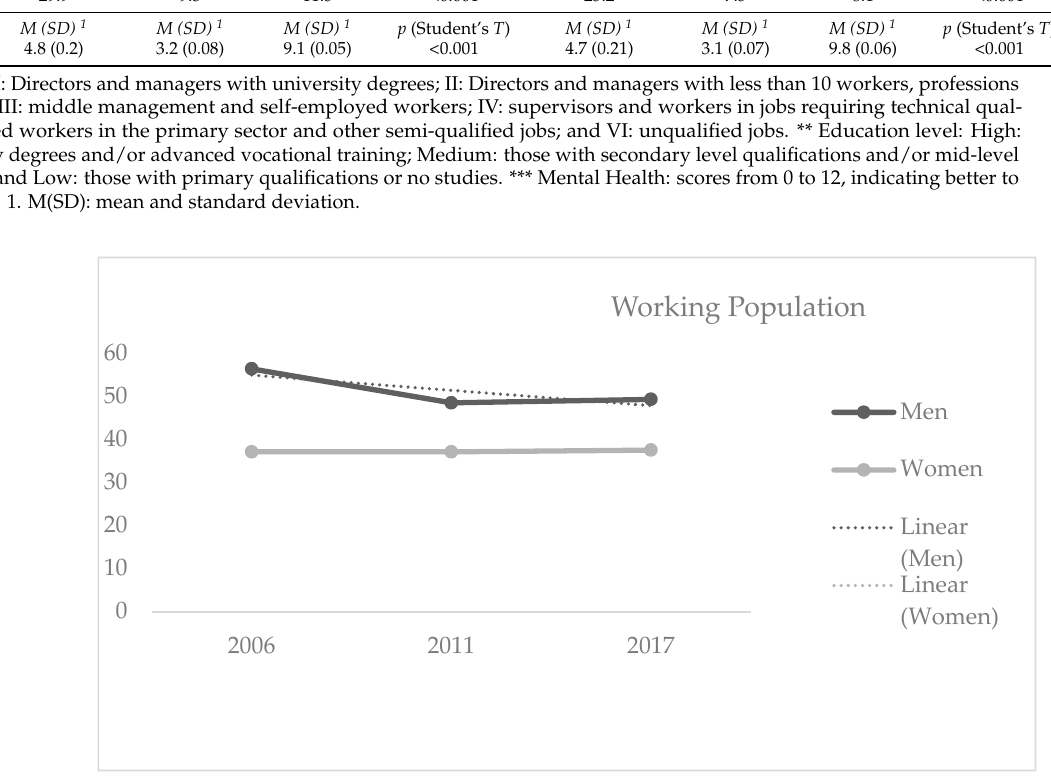
Figure 1. Working population (%) by year of study (2006–2017), disaggregated by sex.